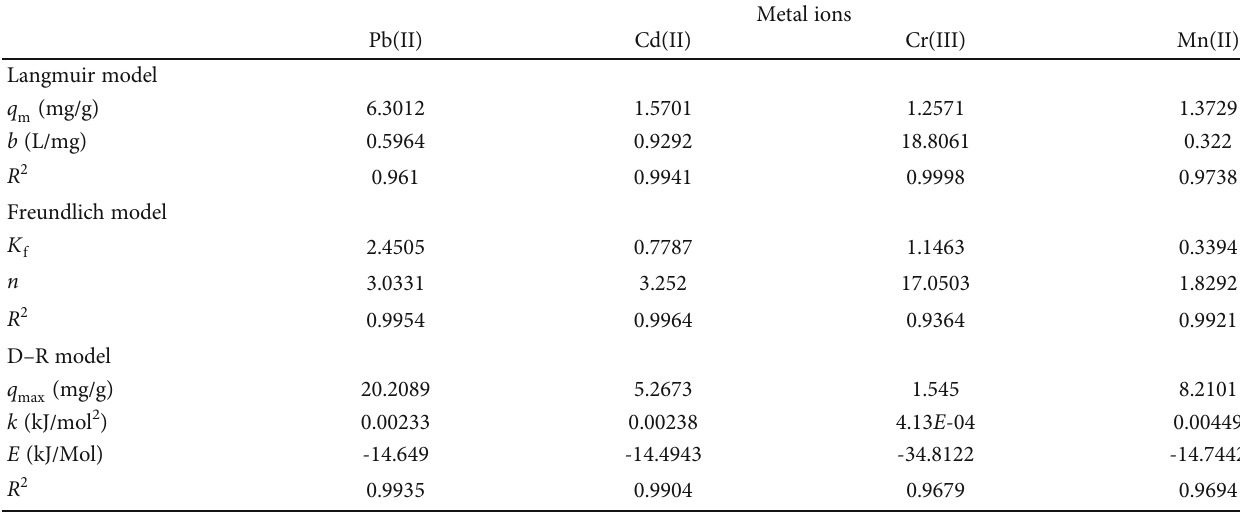
Table 2: Isothermal adsorption